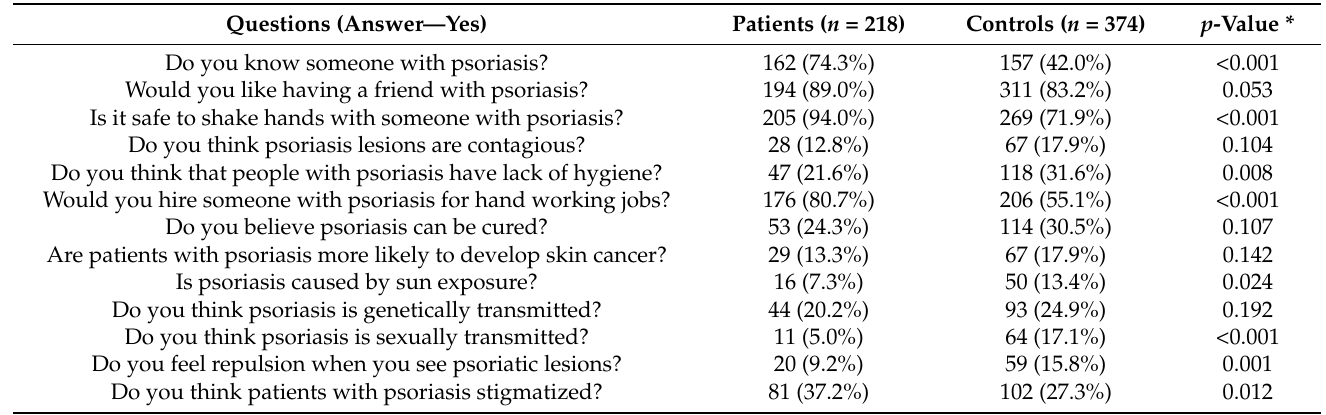
Table 2. Comparison of misinformation and stigmatization as viewed by patients and